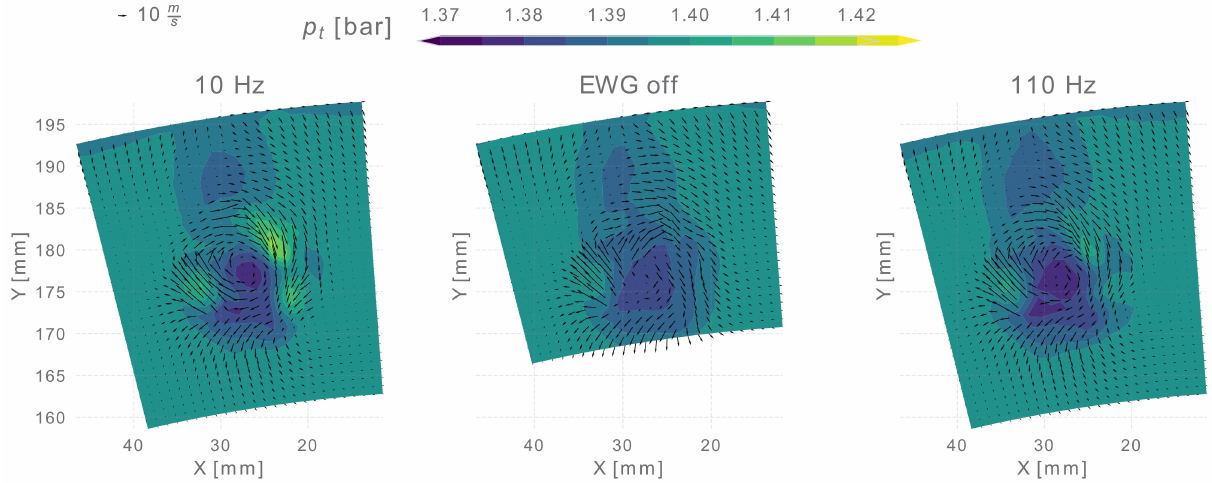
Figure 4. EWG generated disturbance assessment (Plane T1). Total pressure field as a contour and velocities magnitudes as vectors (viewed upstream the injector). From left to right: “10 Hz”, “EWG off” and “110 Hz”